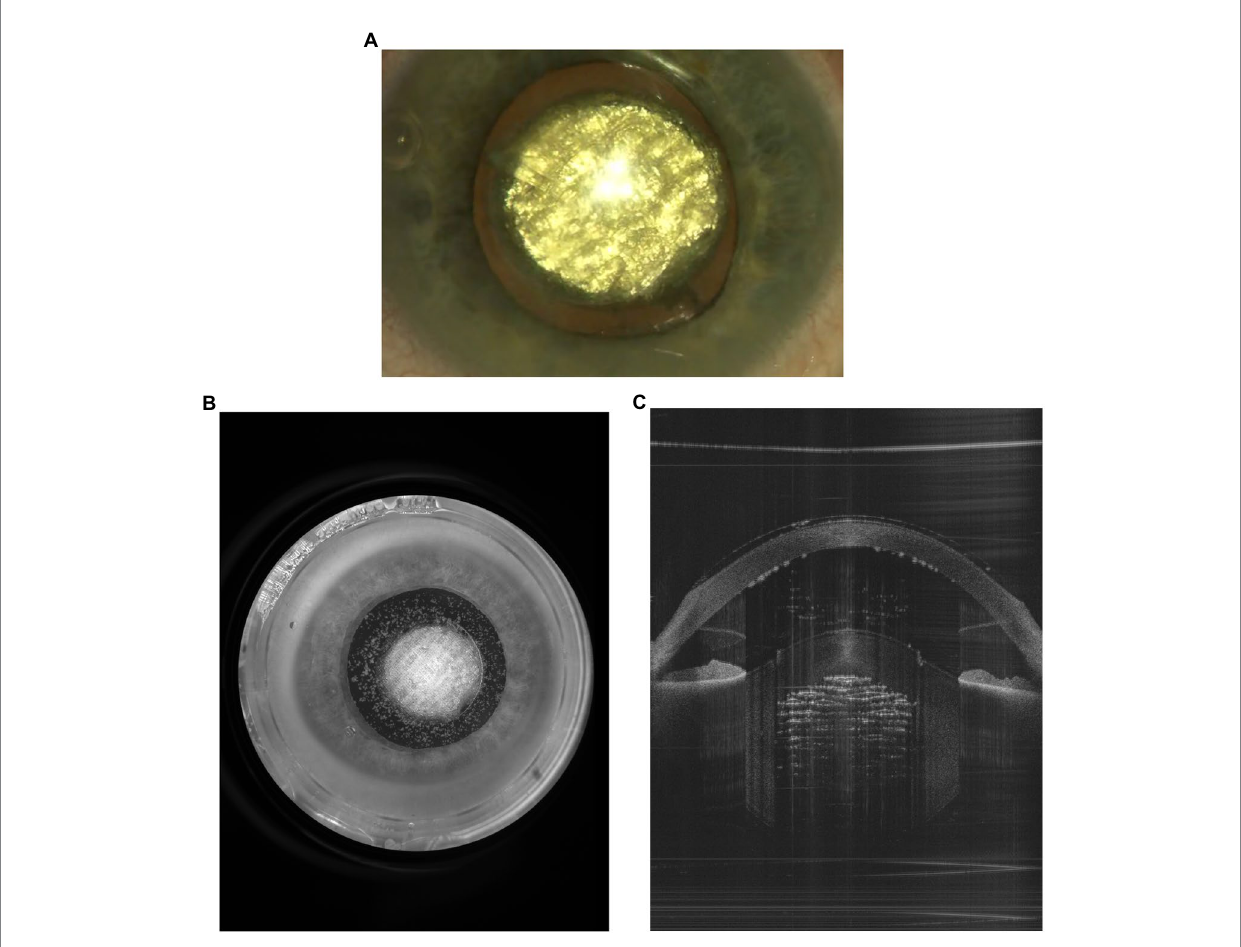
FIGURE 3 PhotoEmulsification ® of a cataracted lens producing 200- μ m cubes sized. (A) View from the surgical microscope, (B) capture from the FemtoMatrix ® system (Frontview camera), (C) capture from the FemtoMatrix ® system